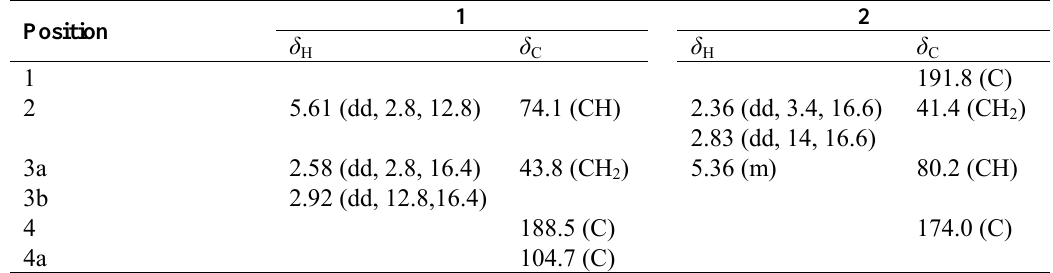
Table 1. 1 H and 13 C NMR data of 1 and 2 in DMSO ( δ in ppm, J in